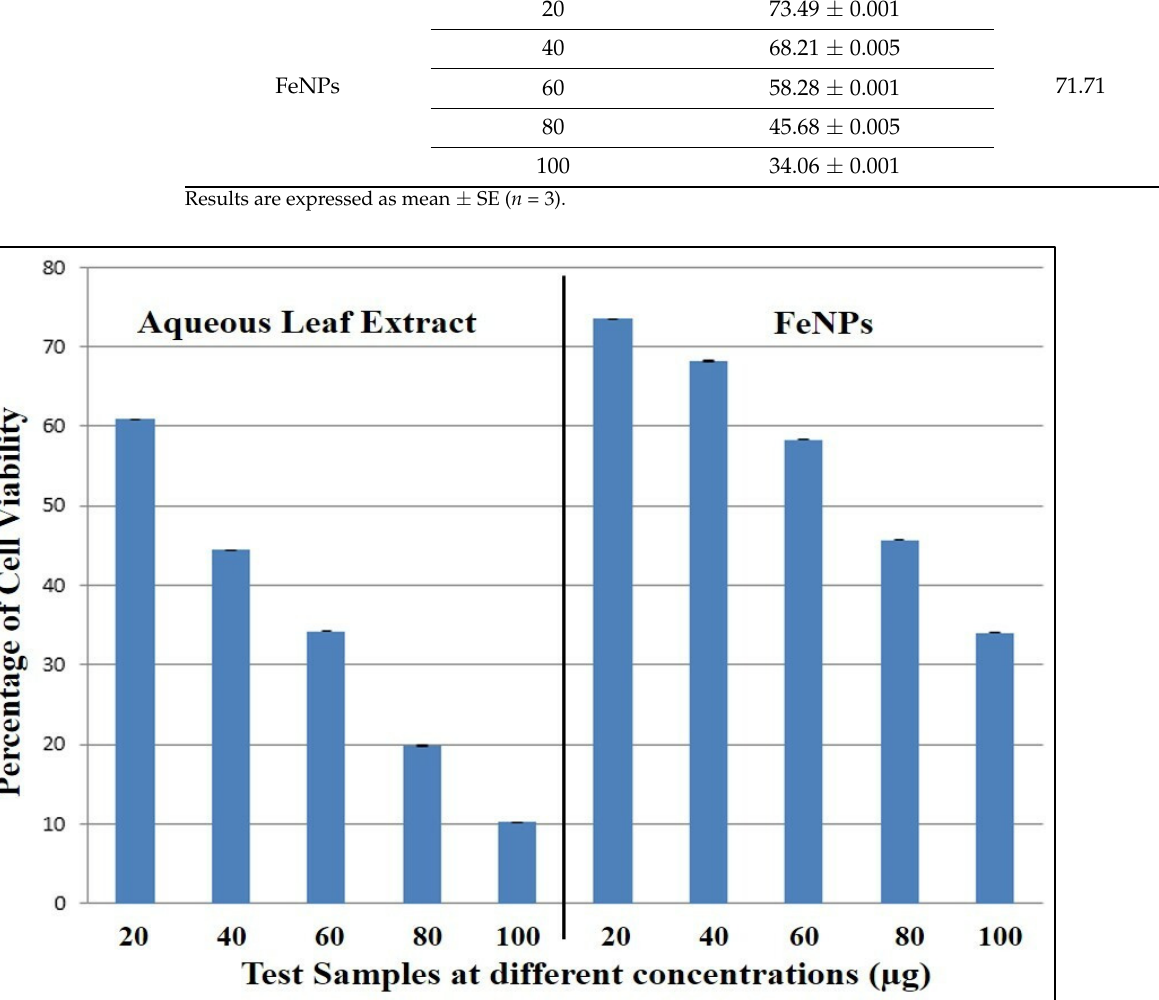
Figure 13. Morphological study of effect of aqueous leaf extract of V. leucoxylon and its synthesized iron nanoparticles against L929 cell line. The scale used is 100 µm. The survival and proliferation of malignant cancer cells are defined by anomalies in systems that regulate the cell cycle in cancer. When cancer develops, a wide range of sig- naling pathways are affected. Cancer formation and radiation and chemotherapy re- sistance are both facilitated by inhibiting natural apoptosis [51]. Cells divide rapidly and continuously in cancer, making it a non-communicable disease [52]. A lack of proper di- agnosis and therapy has been blamed for the high expense of cancer care and cancer theranostics [53]. In terms of cancer fatalities, lung, breast, and colorectal cancers have the